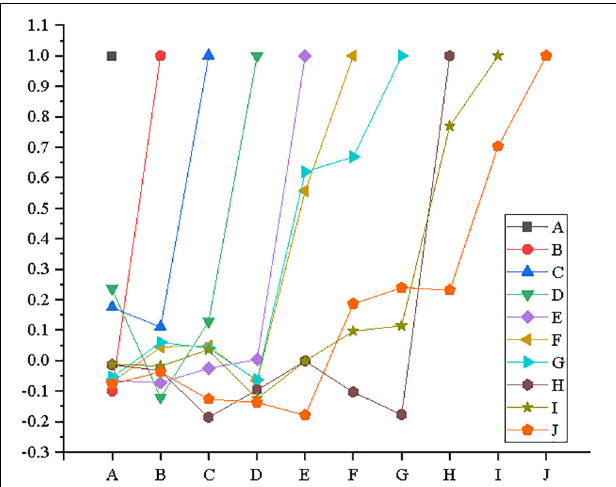
FIGURE 7 | Correlation analysis among variables (A: educational background; B: employees’ gender; C: employees’ age; D: company size; E: model innovation; F: entrepreneurial self-efficacy; G: entrepreneurial behavior; H: continuance commitment; I: normative commitment; and J: affective